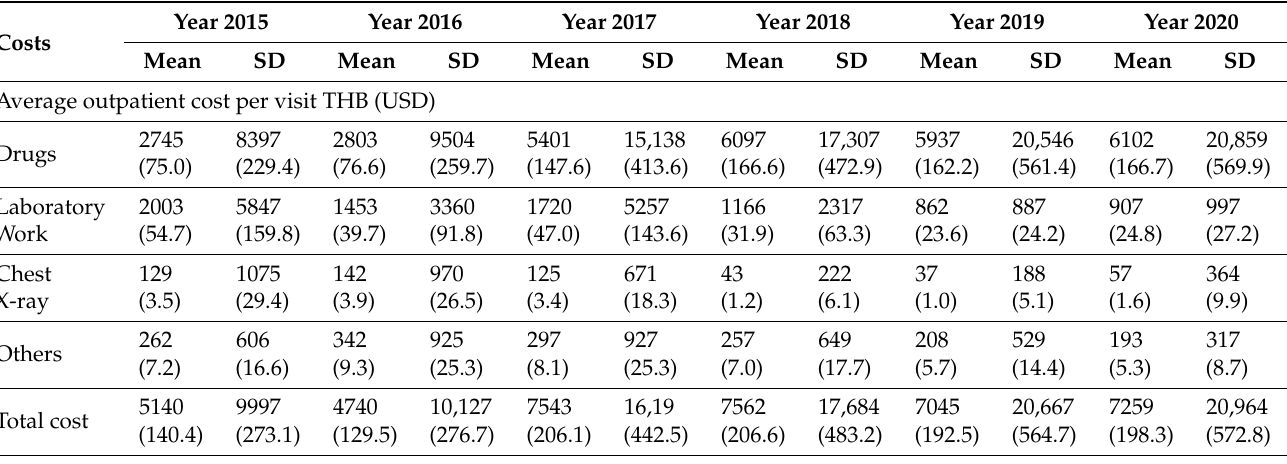
Table 4. Average costs of outpatient and inpatient visits.